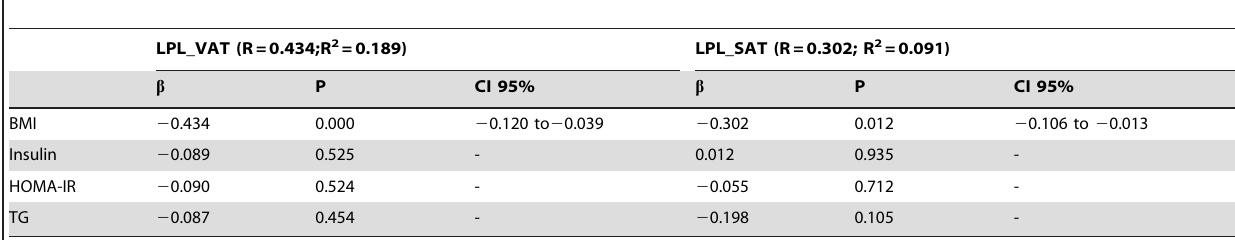
Table 5. Multiple regression analysis for LPL gene expression in VAT and SAT, as dependent variable, in all the study subjects.